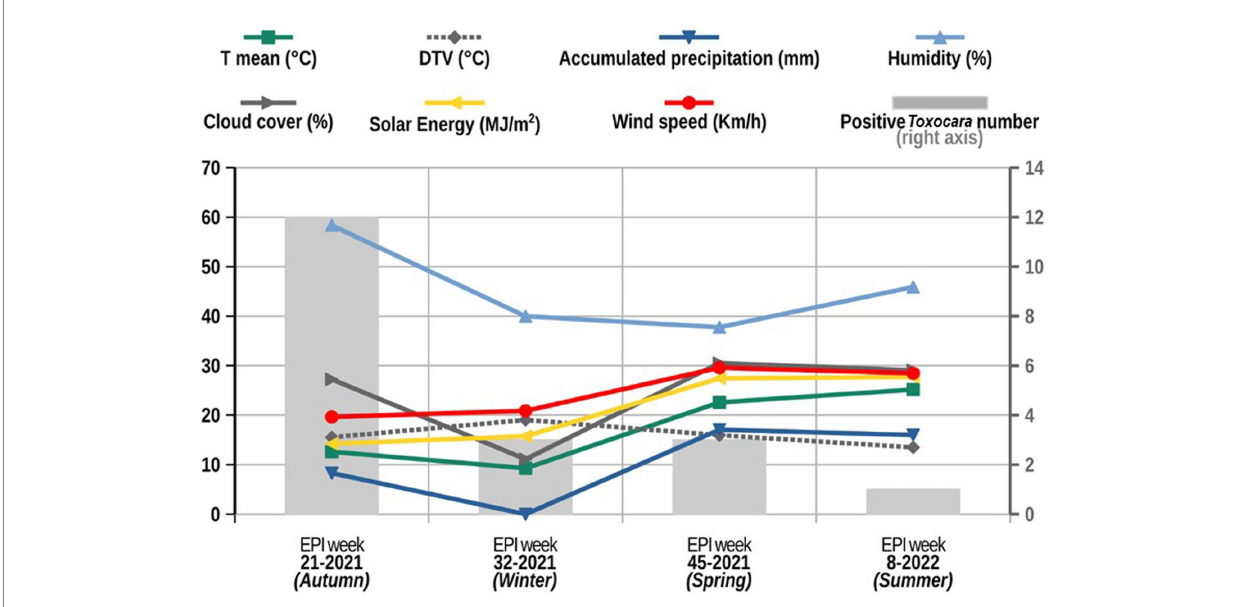
FIGURE 4 Description of the climatic variables retrieved from the weather station from San Juan Airport in San Juan (Argentina) and the number of Toxocara spp. cases found during the sample period (2021–2022). Climatic variables retrieved are shown on the left axis, including mean temperature (T mean in ° C), Diurnal Temperature Variation (DTV), accumulated precipitation (mm), air humidity (%), cloud cover (%), solar energy (MJ/m 2 ) and wind speed (km/h). The number of positive cases of Toxocara spp. found for each season (autumn, winter, spring and summer) is reflected on the right